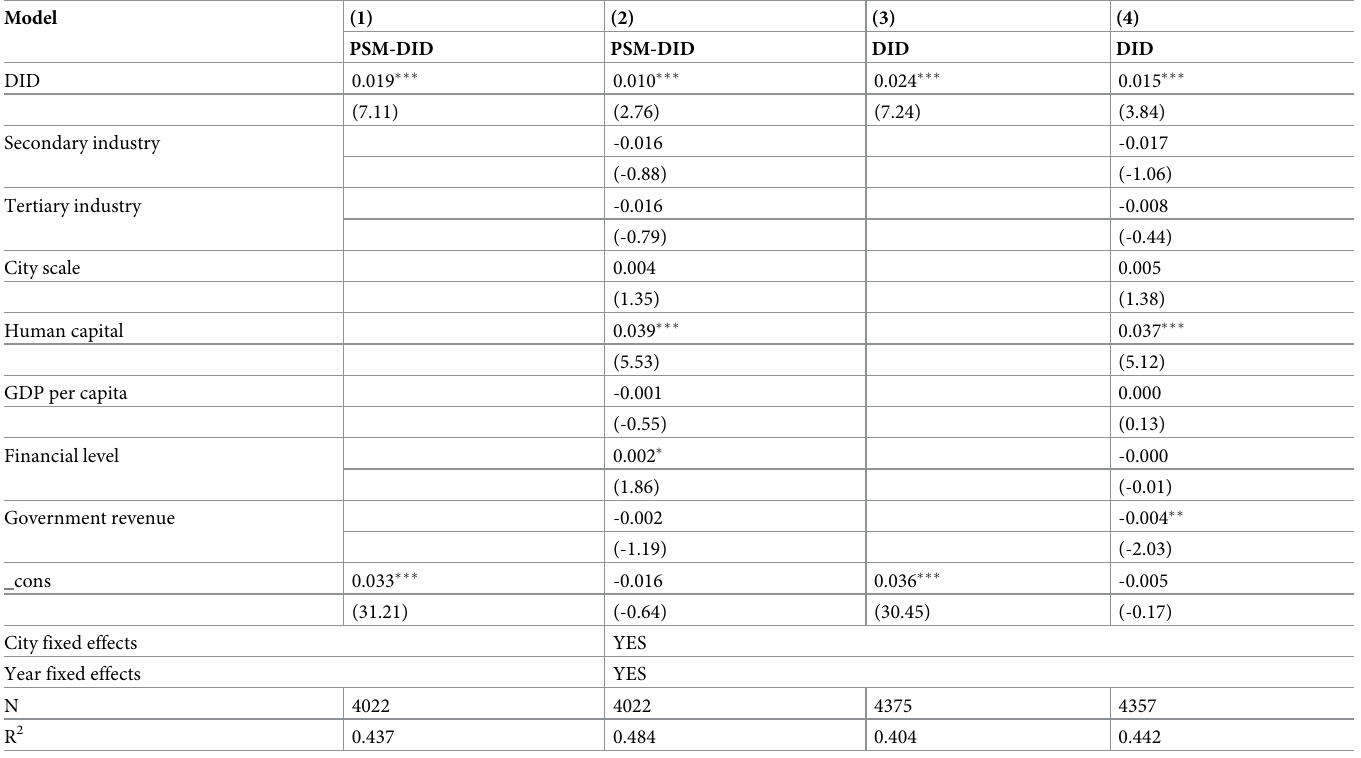
Table 4. Evaluation results of the policy impact on the quality of public services (Explained variable: Public services).